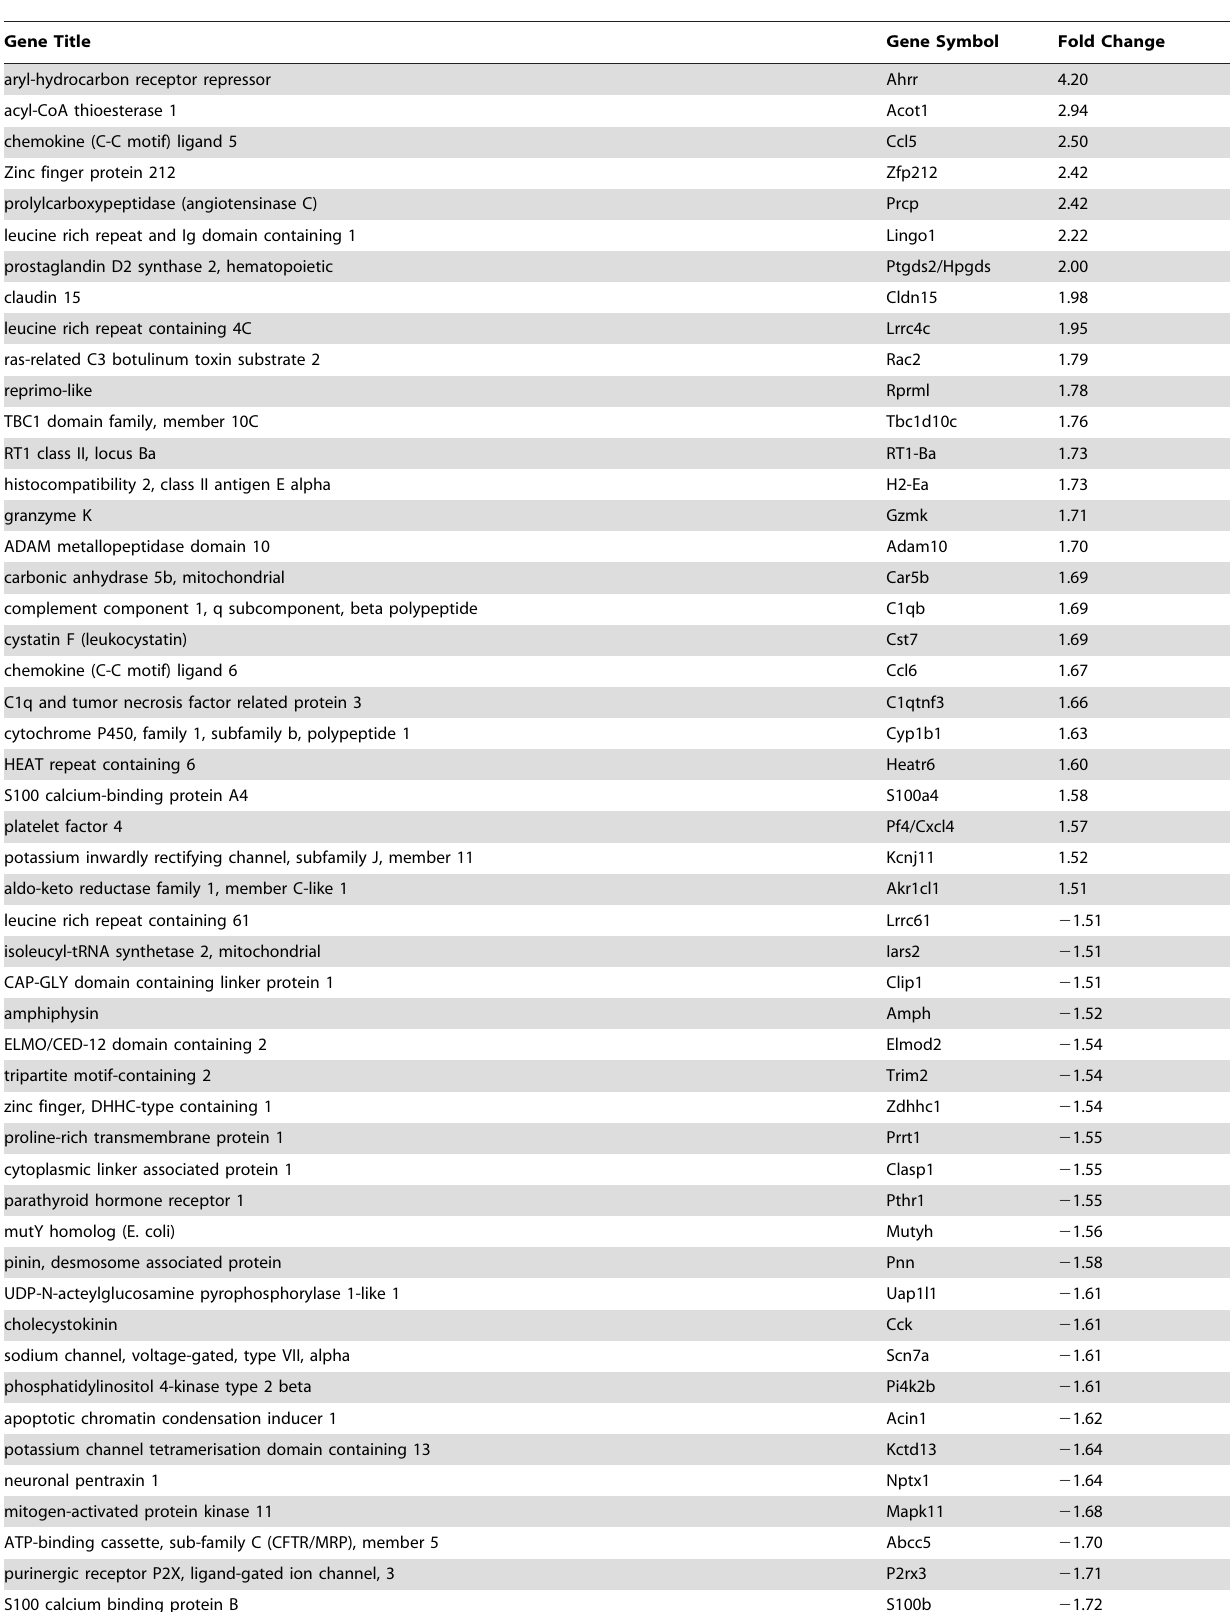
Table 3. Sub-list of characterized genes TCDD-regulated in